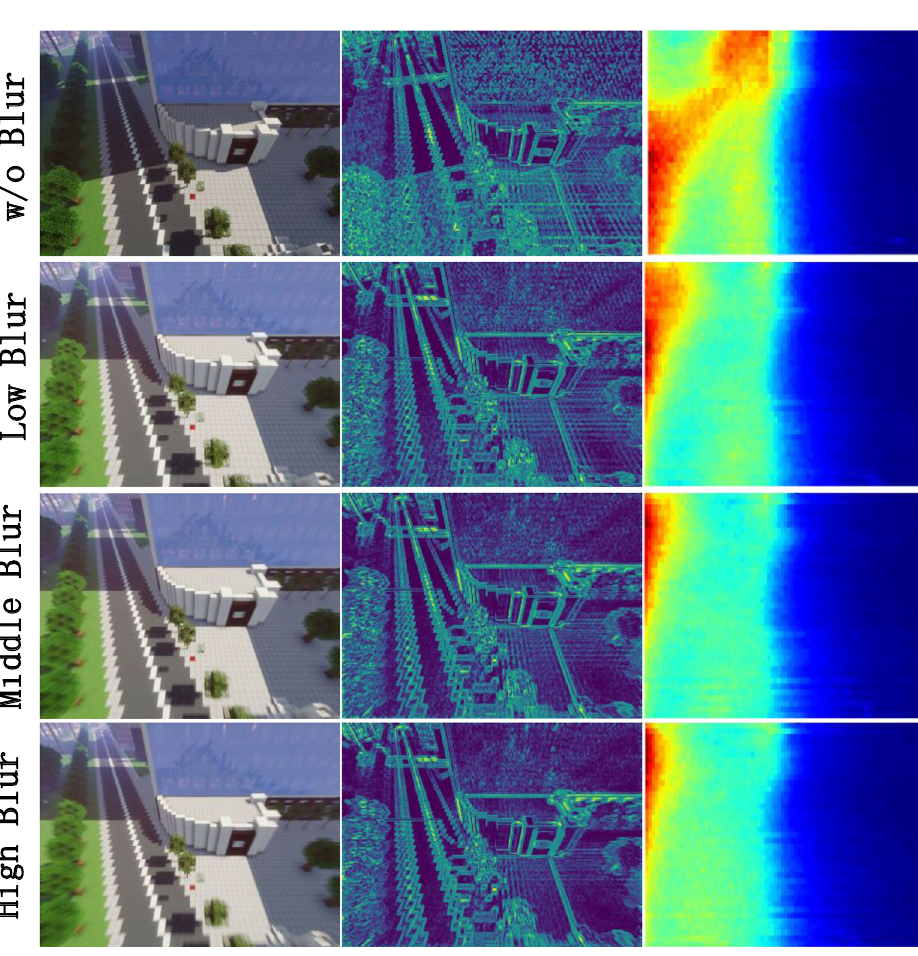
Figure 12. At close to the ground ( sequence photometric error heat